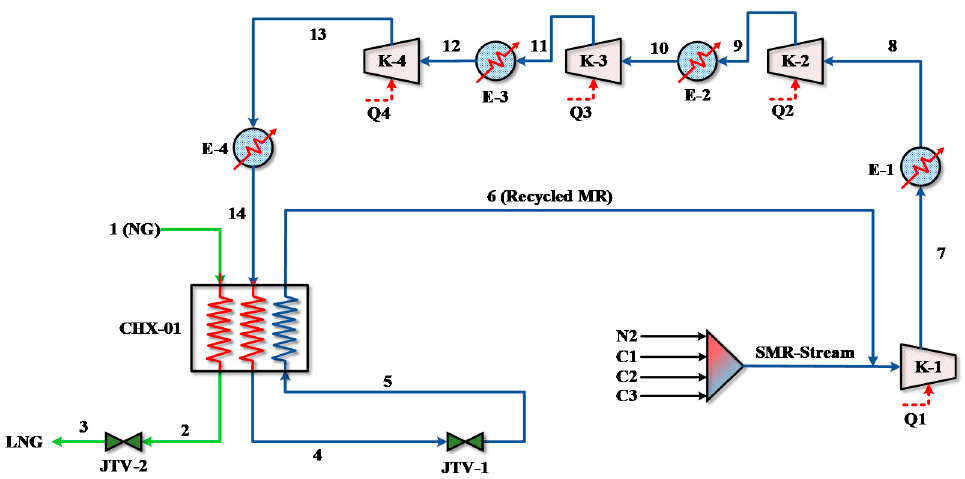
Figure 3. Schematic diagram of the single mixed refrigerant (SMR) LNG process [20].